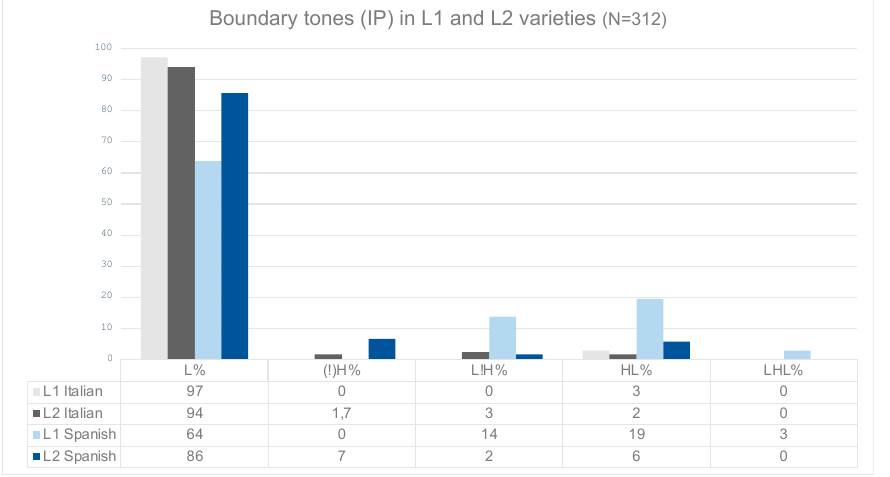
Figure 16. Tonal patterns of all boundary tones at the intonational phrase found in all L1 and L2 data (in %).